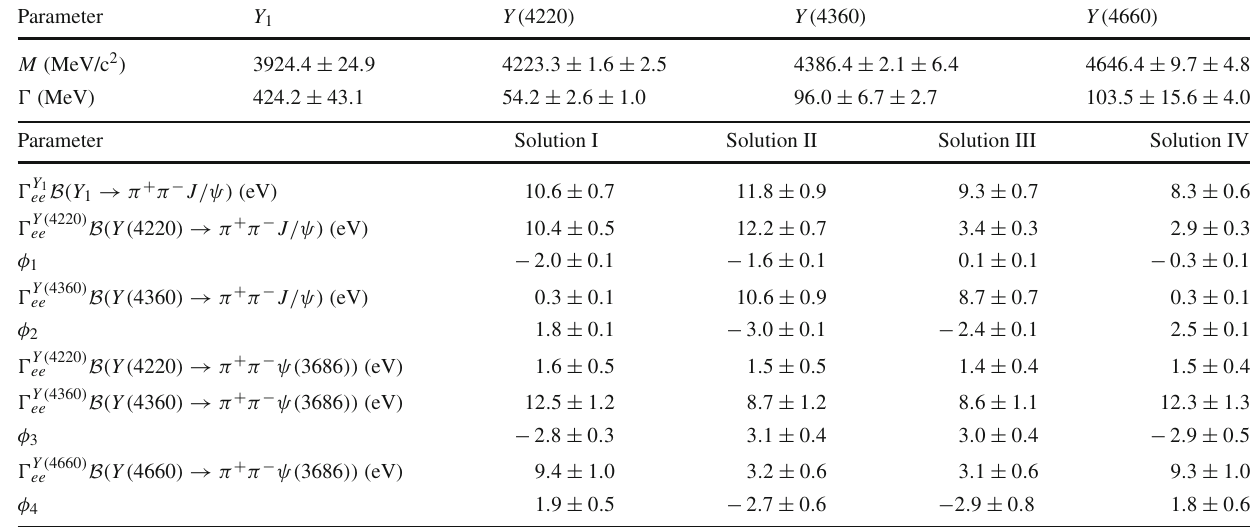
Table 2 The fitted parameters from the combined fit to the cross sections of e + e − → π + π − J /ψ and e + e − → π + π − ψ( 3686 ) . The errors are statistical. For Y ( 4220 )/ Y ( 4360 )/ Y ( 4660 ) M and (cid:4) , the first errors are statistical, the second are systematic Parameter Y 1 Y ( 4220 ) Y ( 4360